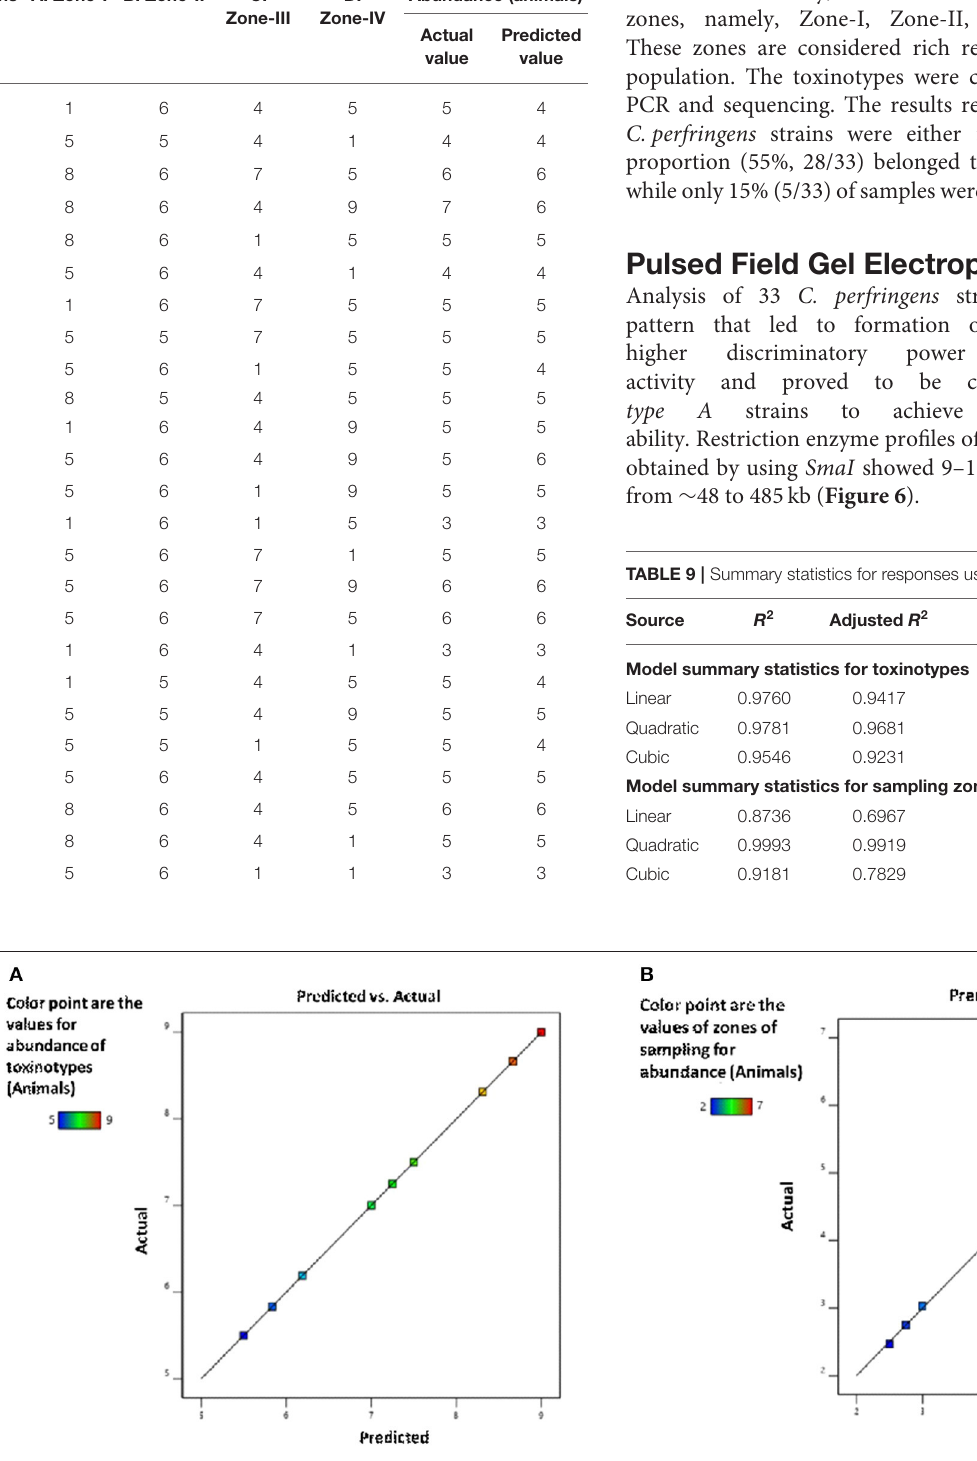
FIGURE 5 | Validation of the model for (A) toxinotypes and (B) zones of sampling for the assessment of C. perfringens abundance in the buffalo and cattle population of Punjab province, Pakistan.